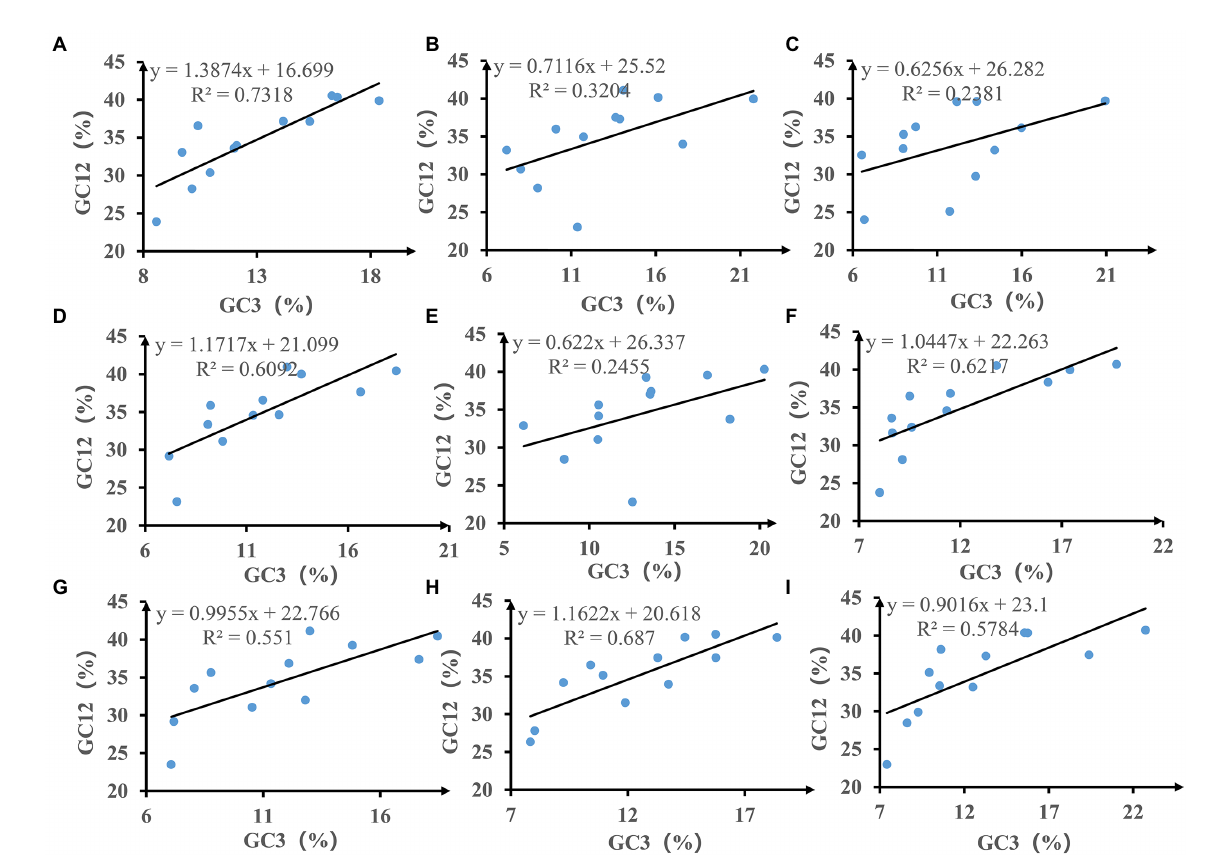
FIGURE 3 Neutrality plot analysis of GC12 and the third codon position (GC3) for the entire coding DNA sequence of nine Amanita species. (A) , A. basii ; (B) , A. bisporigera ; (C) , A. brunnescens ; (D) , A. muscaria ; (E) , A. phalloides ; (F) , A. pseudoporphyria ; (G) , A. sinensis ; (H) , A. inopinata ; and (I) , A. thiersii